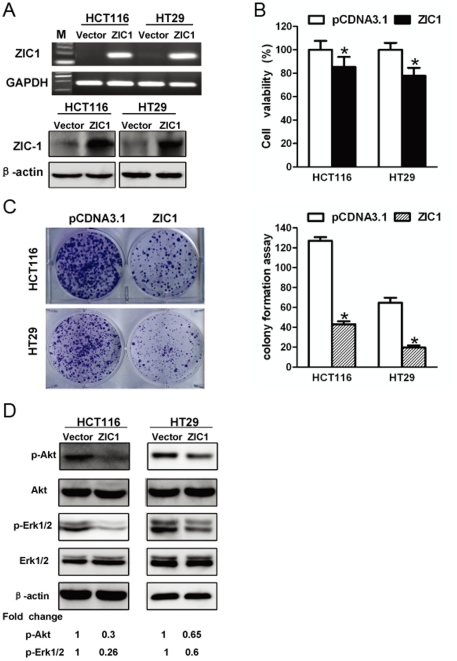
ZIC1 inhibits the proliferation of colon cancer cell and regulates MAPK, PI3K/Akt pathways.(A) Re-expression of ZIC in stable transfectants in colon cancer cells (HCT116 and HT29) was confirmed by RT-PCR (upper lane) and western blot (low lane), GAPDH and β-actin used as internal control. (B) Cell viability assay after ZIC1 re-expression in colon cell lines (HCT116 and HT29). The number of viable cells was measured by MTS assay after transiently transfected with pCDNA3.1-ZIC1 or pCDNA3.1 vector. The assay was performed in triplicate. The asterisk indicates statistical significance (p<0.05). (C) The effect of cell proliferation inhibition by ectopic expression of ZIC1 was determined by colony formation assay in colon cancer cells. The quantitative analysis of colony numbers formed in pCDNA3.1-ZIC1 or pCDNA3.1 vector transfectants are shown in right bar diagram in three individual experiments in HCT116 and HT29 cells. The asterisk indicates statistical significance (p<0.05). (D) The expression phos-Akt and phos-Erk1/2, as well as the total of Akt and Erk1/2 were analyzed by western blot. Band densities were quantified and protein levels (p-Akt, p-Erk1/2) were normalized to β-actin. Densitometry values (ZIC1 transfectants) are expressed as fold change compared with vector transfectants values normalized to 1.